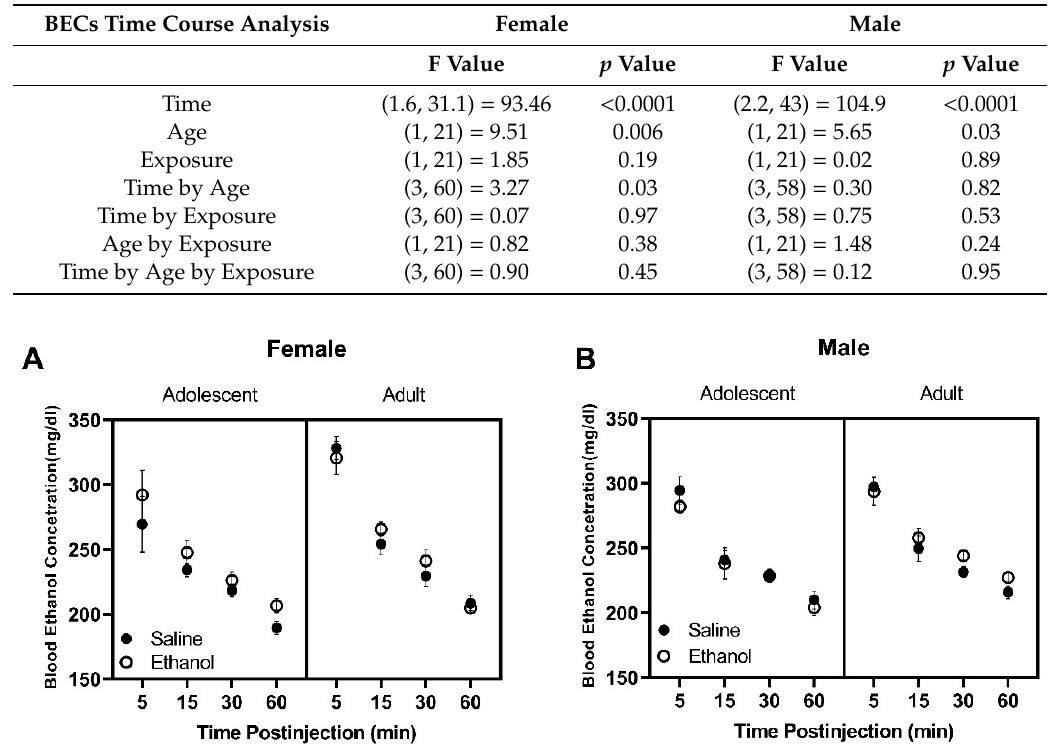
Figure 6. Data are presented as blood ethanol concentration (mg / dL) in response to 1.75 g / kg i.p. ethanol across time in female (Panel A ) and male (Panel B ) rats pre-exposed to saline or 0.75 g / kg ethanol during adolescence or adulthood.